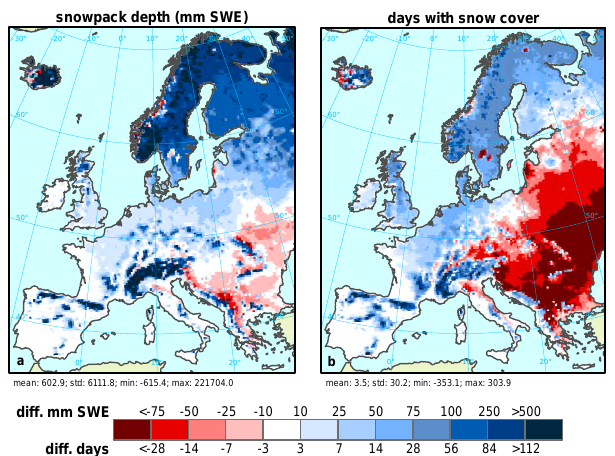
Fig. 9. Difference for LISFLOOD hydrological simulations driven by uncorrected and bias corrected climate data for the control period 1961–1990 for (a) snowpack depth (mm SWE) and (b) days with snow